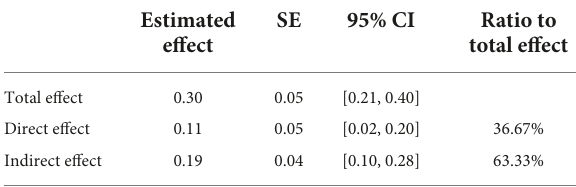
TABLE 3 Bootstrapping indirect effect and 95% confidence interval (CI) for the mediation